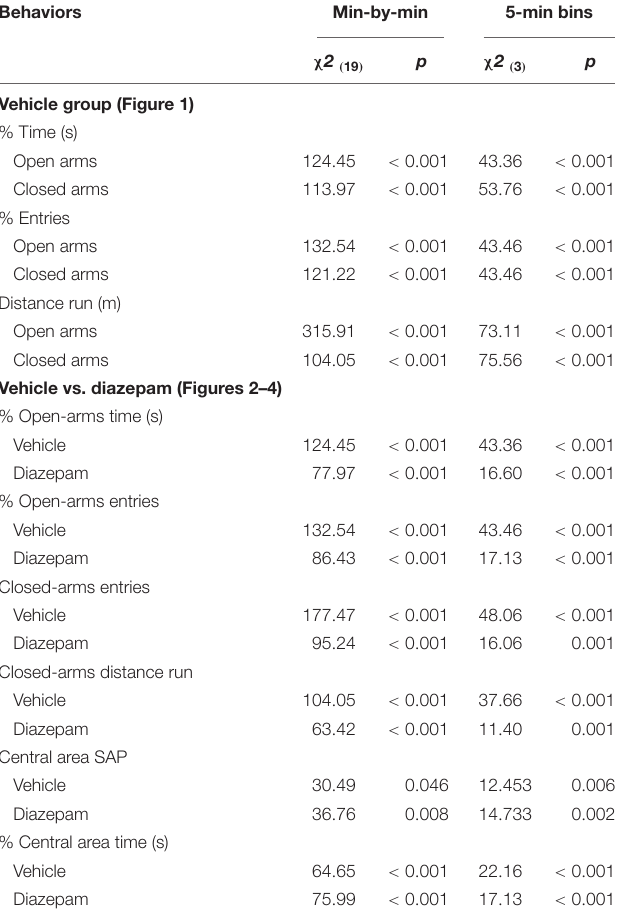
TABLE 1 | Summary of statistical parameters from minute by minute and 5-min bins analysis of the session time in the EPM. Behaviors